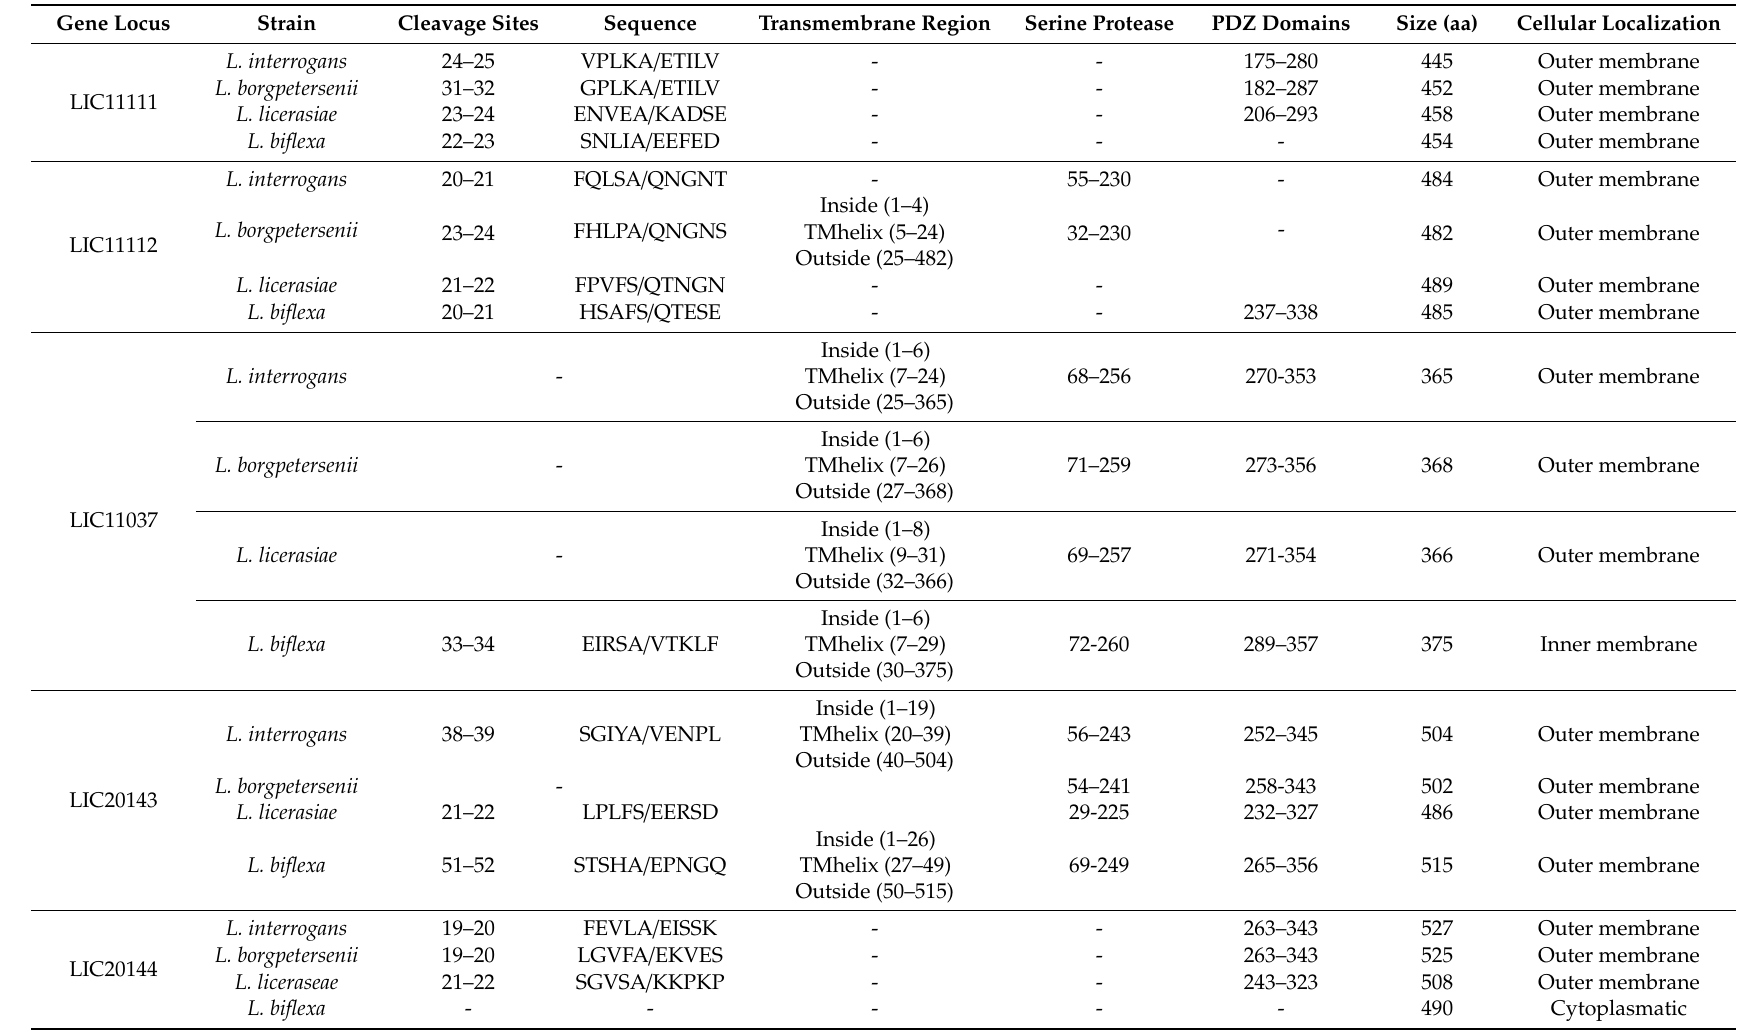
Table 1. Features of HtrAs Coding